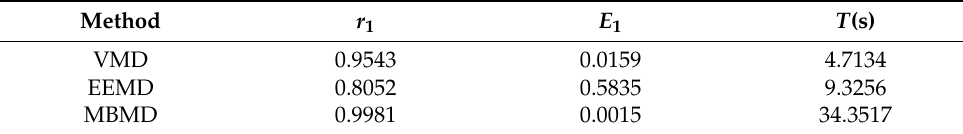
Table 1. Evaluation parameters of the three algorithms (SNR 25).